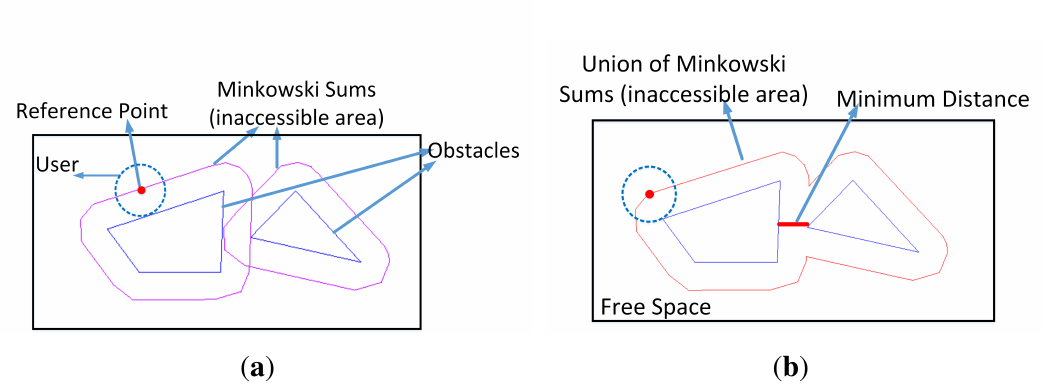
Minkowski sums of obstacles to a user and the minimum distance between obstacles. ( a ) Minkowski sum of obstacles for a user approximated as a circle; ( b ) union of the Minkowski sum of obstacles and the minimum